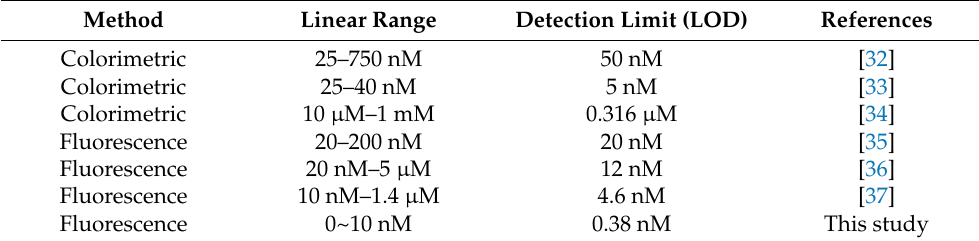
Table 1. A comparison of our method with other methods for Hg 2+